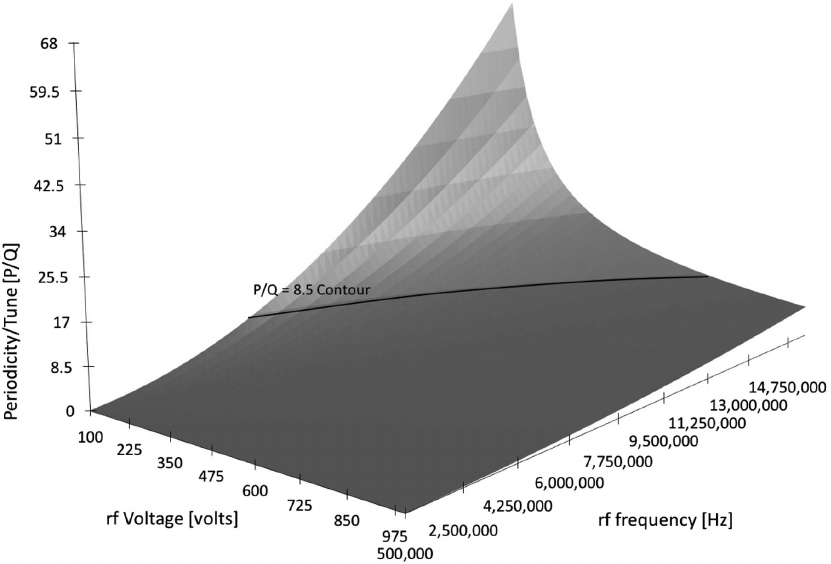
FIG. 1. The surface of values of P=Q for a range of rf frequencies and voltage for 7 Li þ ions with v 0 ¼ 100 m = s, r 0 ¼ 2 . 5 mm, and C ¼ 1